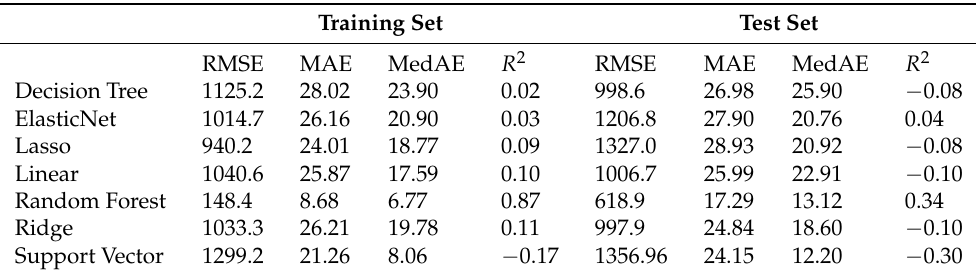
Table 6. Other regression models for the execution time of the dual simplex algorithm. Training Set Test